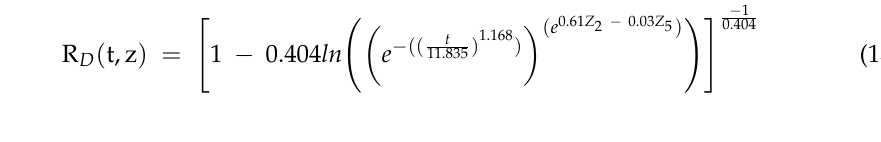
Table 5. The results (PHM) for regression coefficients excavator